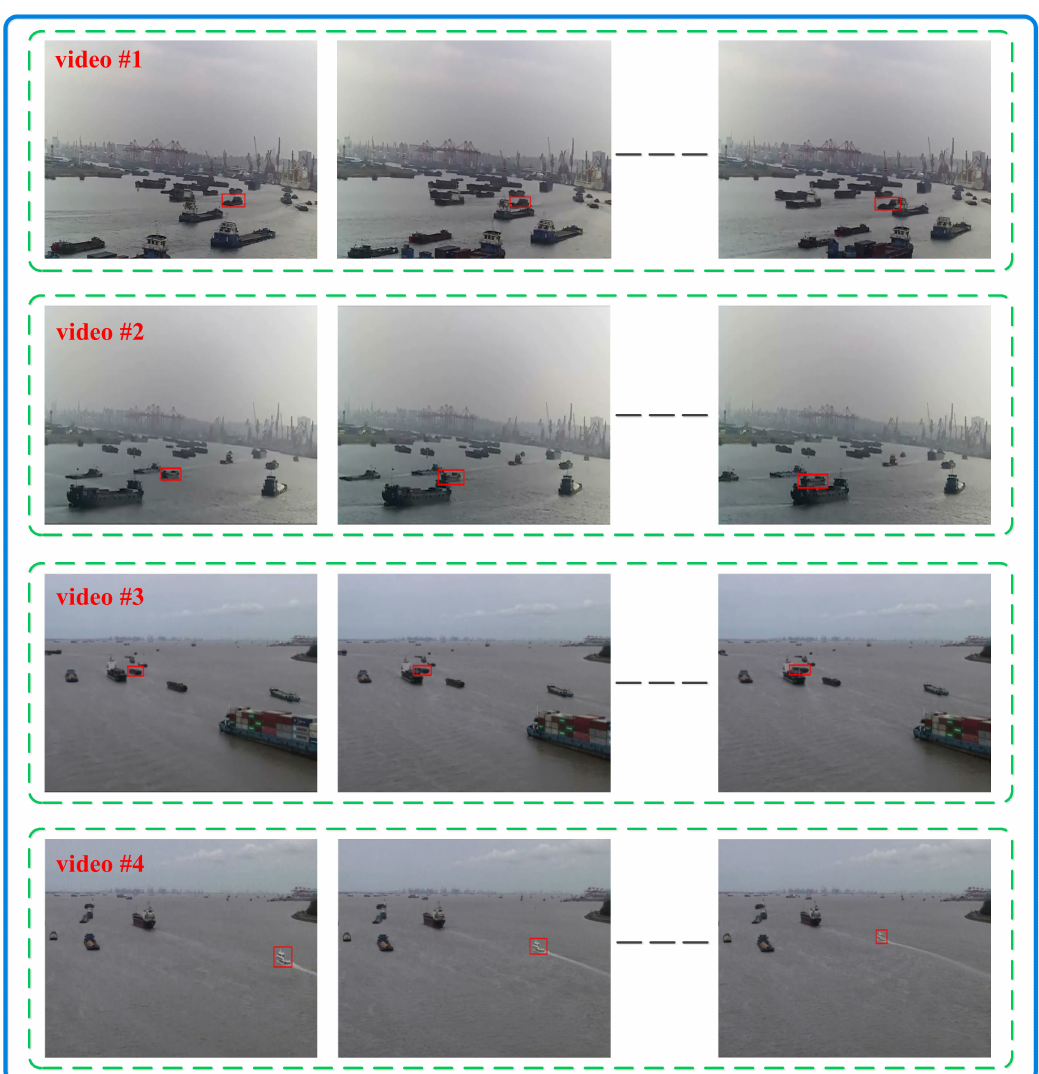
Figure 2. Ship frame samples for the collected video